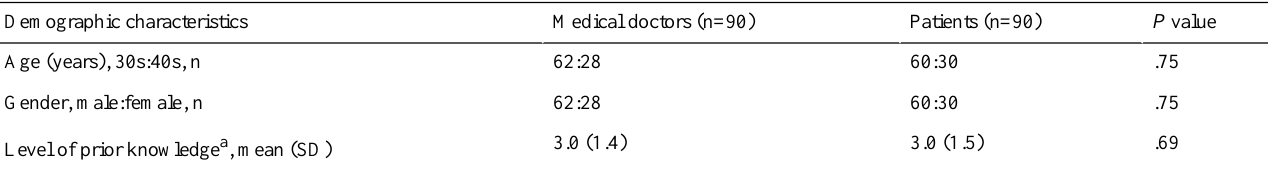
Table 1. Significance of the difference in the demographic characteristics of medical doctors and patients.